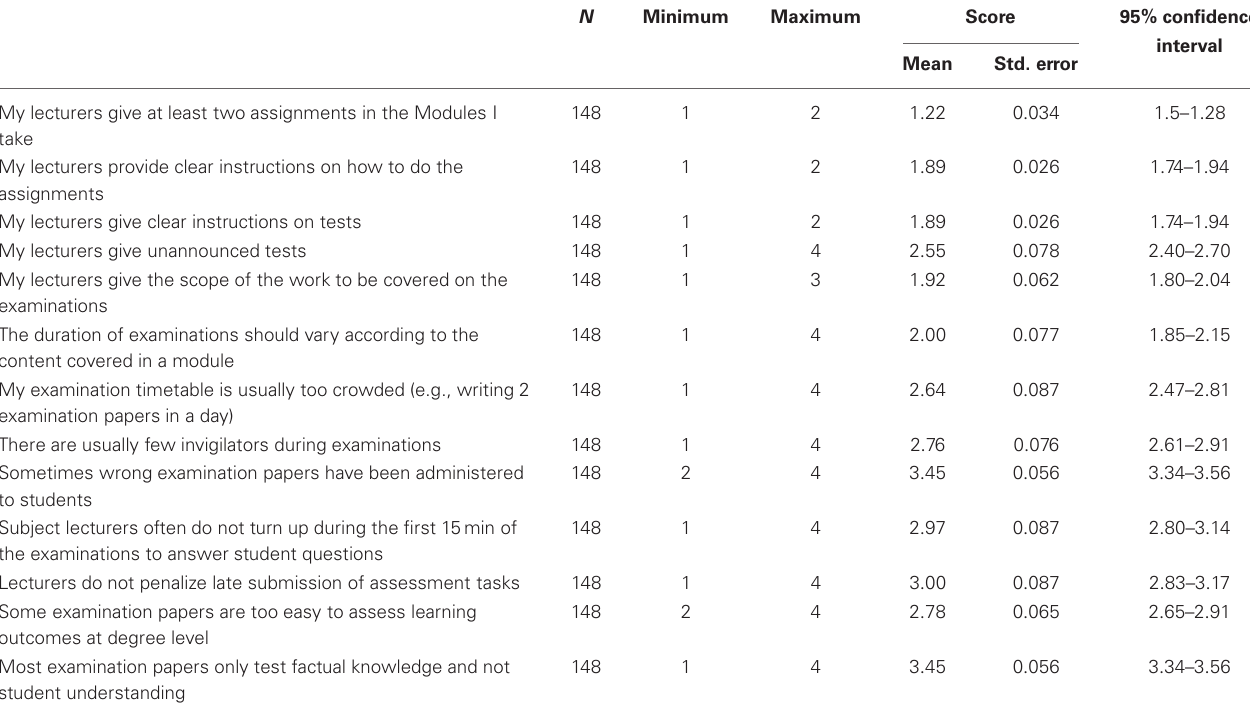
Table 1 | Experiences and practice of assessment at the University of Namibia as perceived by the respondents.